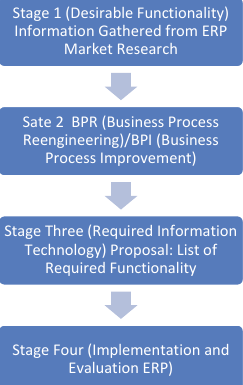
Fig. 1. ERP Project Development